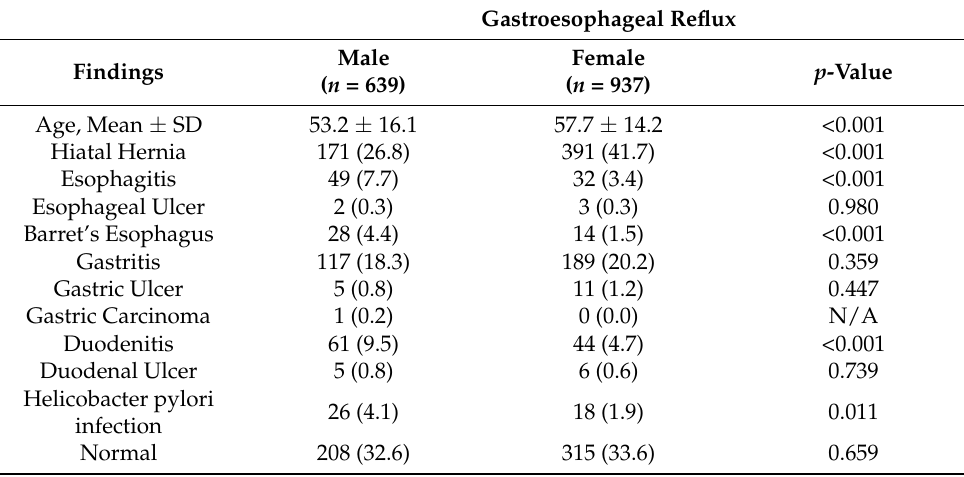
Table 2. Upper endoscopy findings for the indication of gastroesophageal reflux.